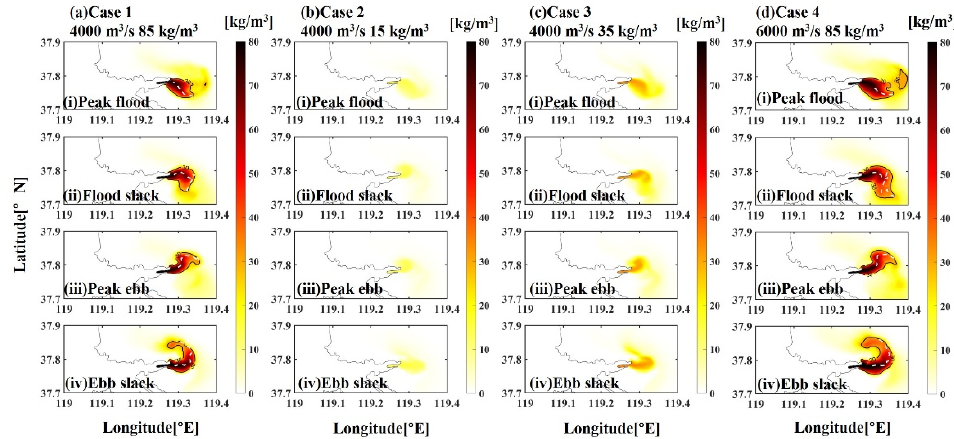
Figure 8. Bottom SSC at different times for different cases ( a – d ) representing Case 1–4, respectively: ( i ) peak flood; ( ii ) flood slack; ( iii ) peak ebb; ( iv ) ebb slack. Note that Case 1 is the reference case and the white dash lines in the figures connects the point on the isoline where the sediment concentration varies from 30 to 80 kg/m 3 at the farthest distance from the river mouth. Note that there are no white lines in Figure 8b,c, which represent Cases 2 and 3, respectively, because the SSC in these two cases were less than 80 kg/m 3 .